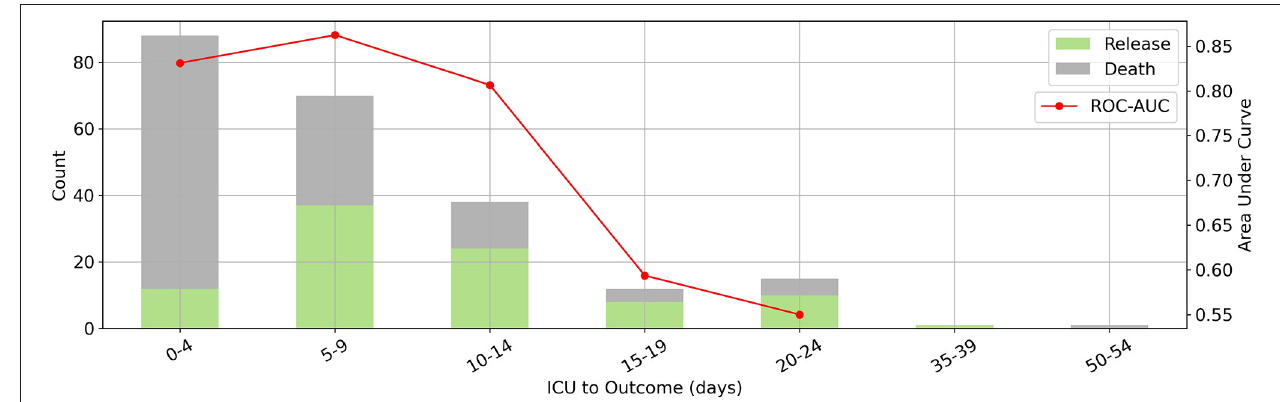
FIGURE 3 | The relation between prediction horizon and performance. Where x-axis denotes days from ICU admission to outcome. Distribution of days between intensive care unit admission and outcome (bars on the left vertical axis) and corresponding random forest model’s area under the receiver operating characteristic curve scores for each bin (red line on the right vertical axis). Our model has the best performance to predict outcomes in a 15-day period.